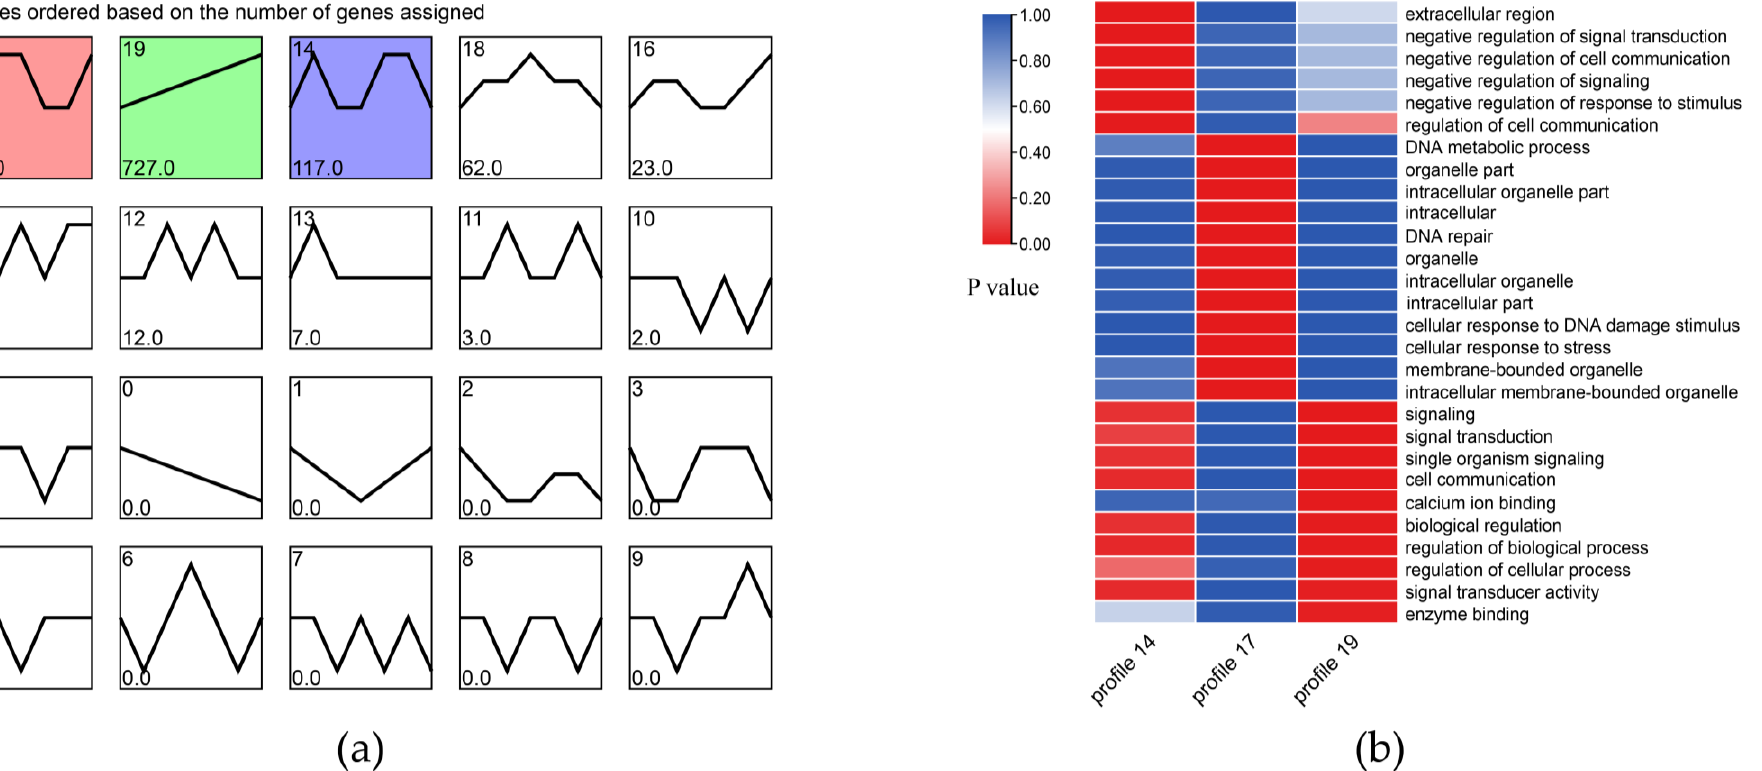
Figure 2. ( a ) Tendency analysis of all DEGs. The trend graph shows three trends of genetic changes. Each number in the upper left corner represents a trend, each number in the lower left corner represents the gene number for each trend type, and colors represent a significant trend ( p < 0.05). ( b ) GO enrichment graph of genes in three trends.